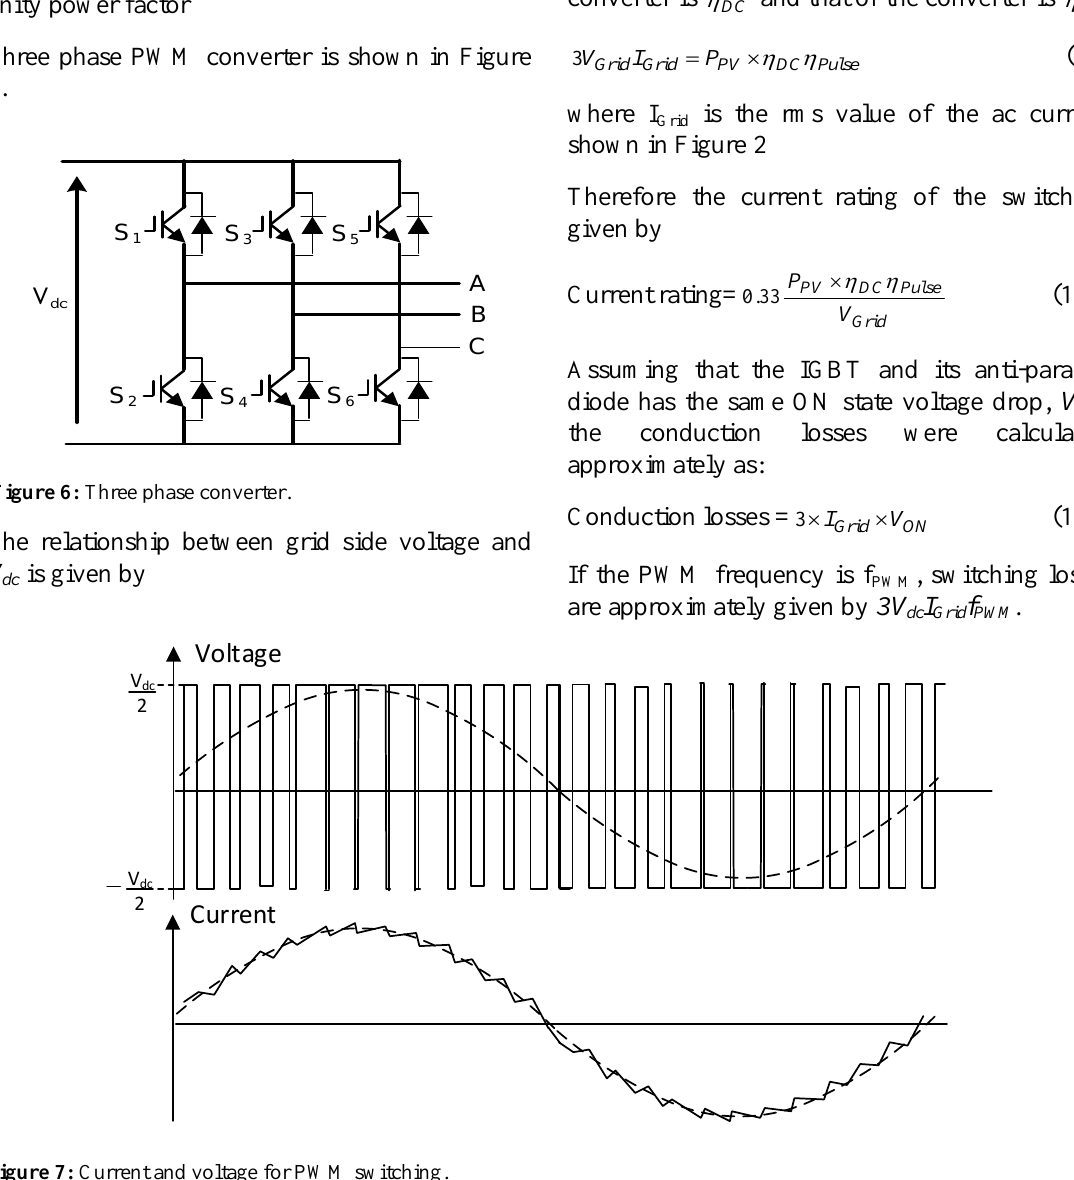
Figure 7: Current and voltage for PWM